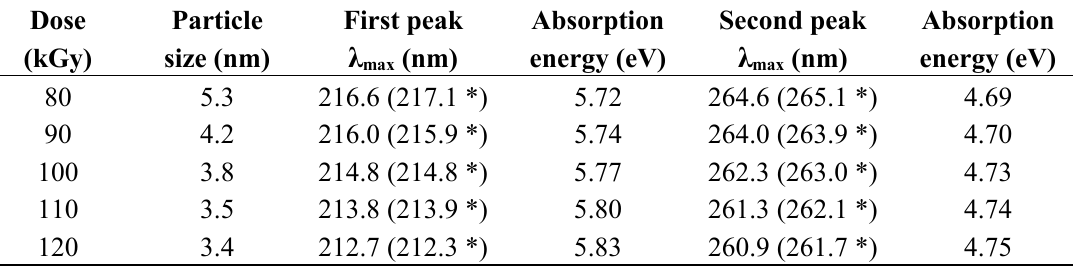
Table 1. Average particle size, absorption peak, and absorption energy of Pt nanoparticles synthesized by the radiolytic reduction method at doses of 80 to 120